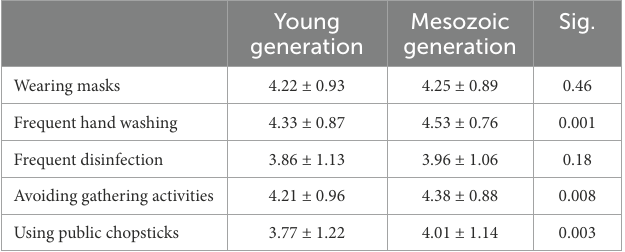
TABLE 4 An analysis of differences in health behaviors between